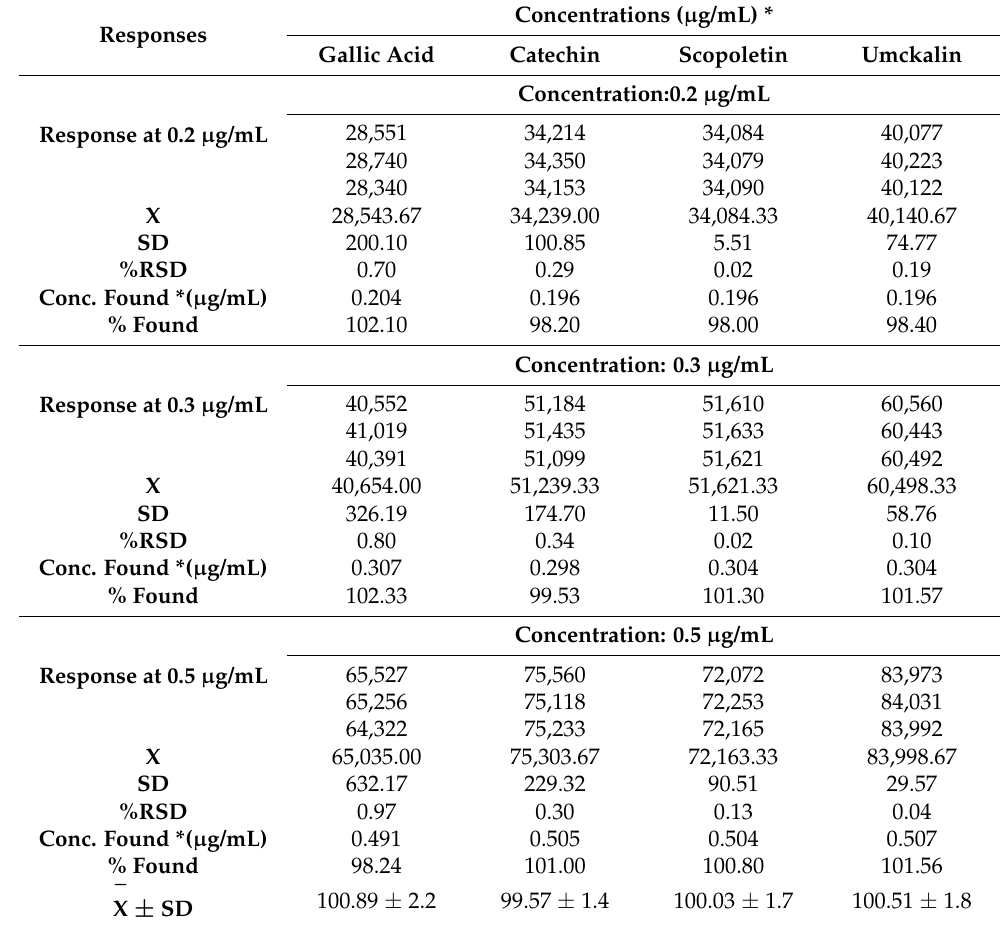
Table 2. Statistical evaluation of the precision and accuracy for the analysis of the biomolecules in their pure forms by the proposed